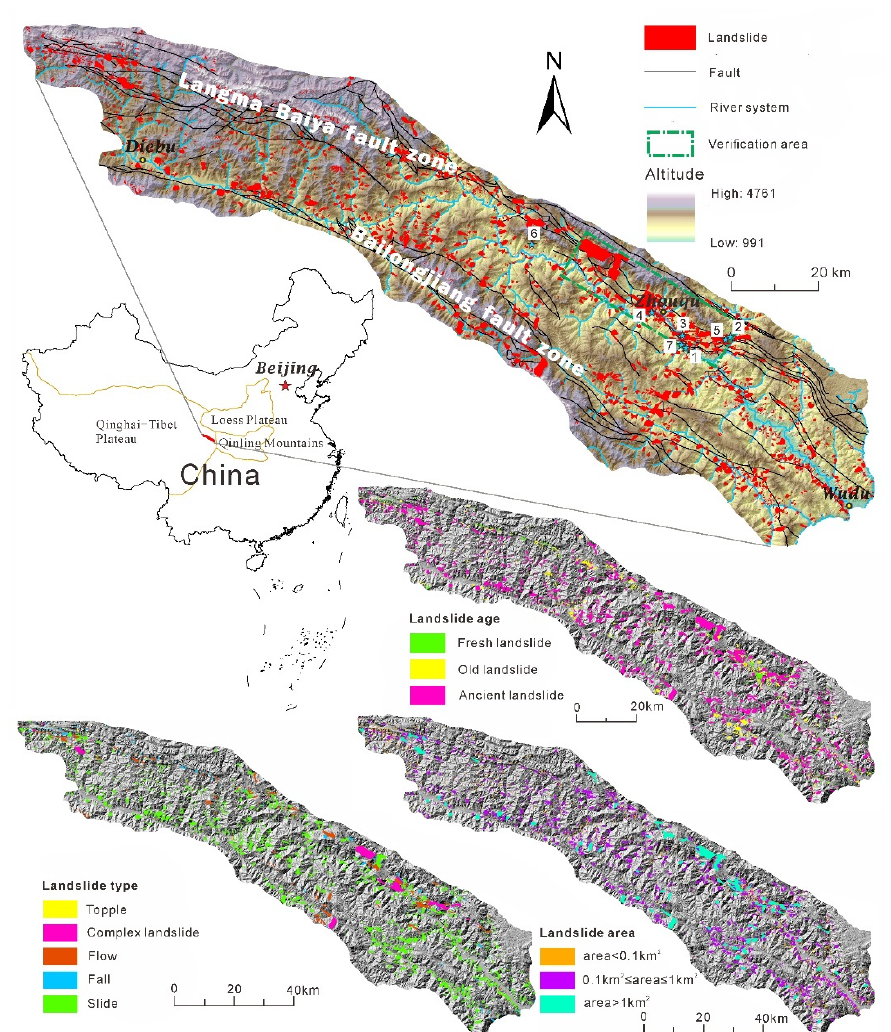
Figure 1. Location of the study area in China and landslide inventory map including unclassified landslides, and the age, area and type of movement of landslides. 1. Location of Figures 2a and 3d; 2. Location of Figure 2b; 3. Location of Figure 3a; 4. Location of Figure 3b; 5. Location of Figure 3c; 6. Location of Figure 3f; 7. Location of Figure